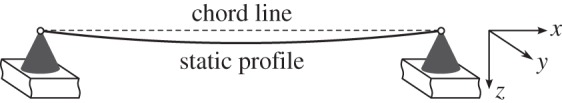
A diagram of an unforced, undamped, horizontal cable. The physical coordinates x, y and z are defined, where x is in the direction of the chord line and z is the direction of gravity.